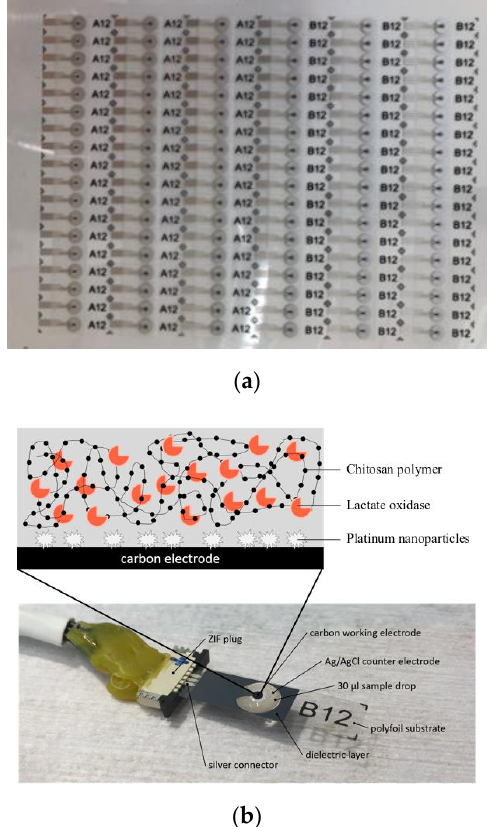
Figure 1. ( a ) An A4-sheet containing 108 screen-printed electrochemical sensors for biosensor development; ( b ) the fabricated electrochemical biosensor. The insert shows the architecture of the enzyme layer with the Pt-nanoparticle-modified carbon electrode surface covered by the enzyme/chitosan membrane.